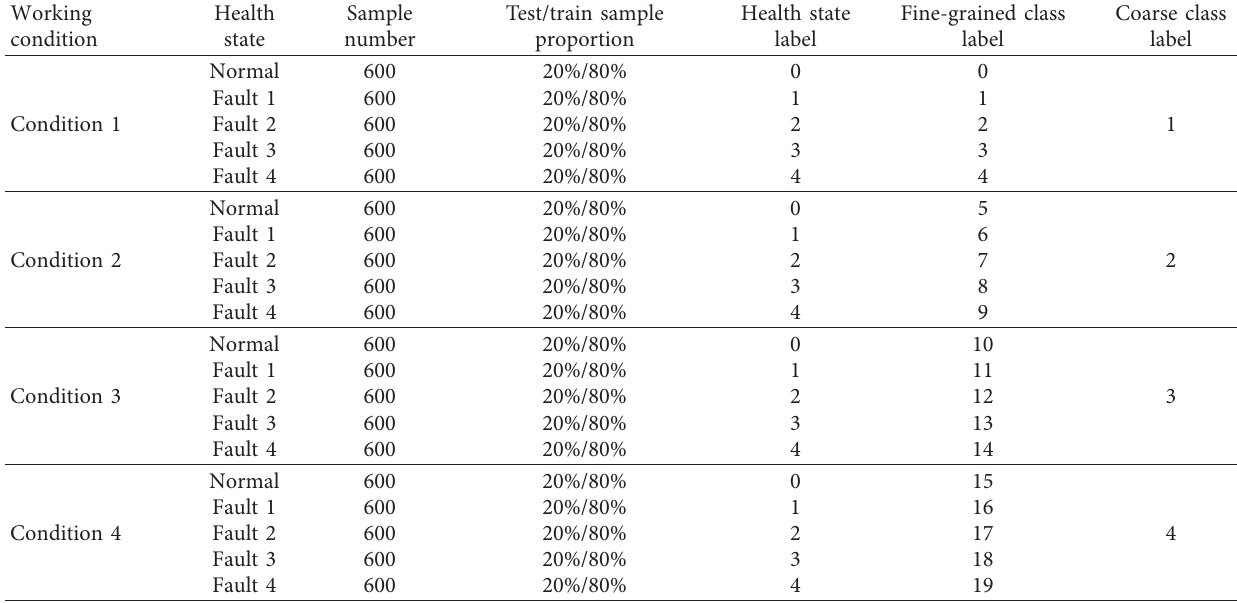
Table 4: Data description of